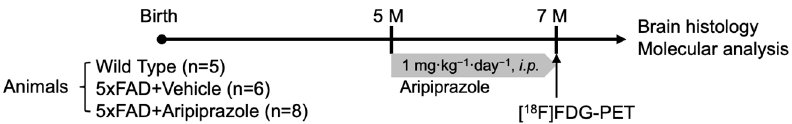
Figure 1. Illustration of experimental design. At the age of 5 months, aripiprazole (1 mg · kg − 1 · day − 1 ) or vehicle were intraperitoneally administered to age-matched wild-type (WT) and 5xFAD for 2 months. At the age of 7 months, animals underwent 18F-fluorodeoxyglucose positron emission tomography ([ 18 F]FDG-PET) image and were then sacrificed for further histopathological and molec- ular analyses.